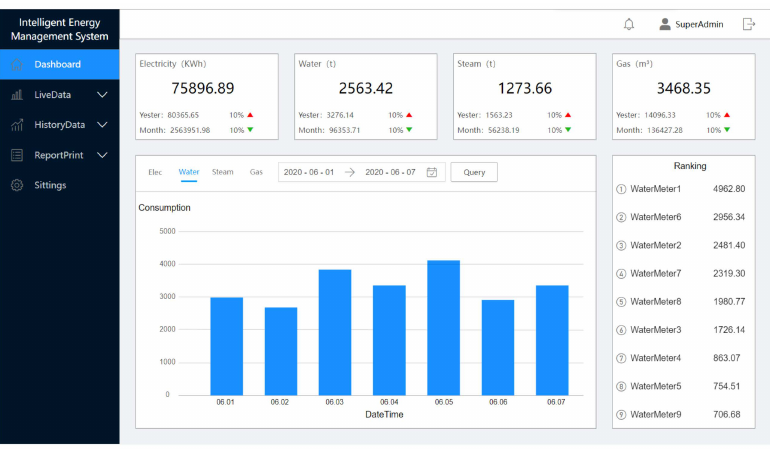
Figure 7. Backend interface.